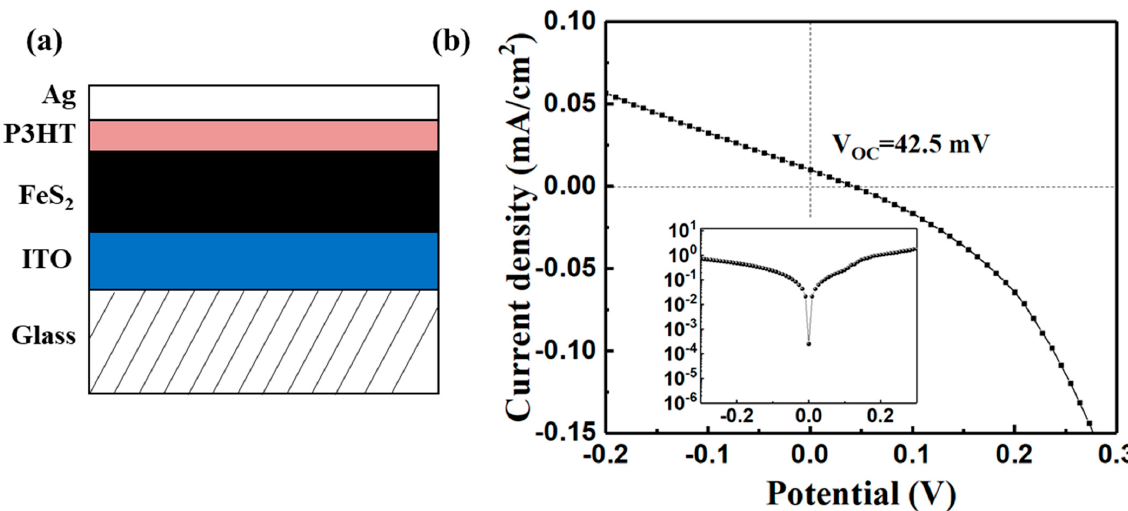
Figure 11. ( a ) Structure of FeS 2 /P3HT heterojunction thin-film solar cell, and ( b ) current density vs. voltage (J-V) characteristics (insert: dark J-V curve).